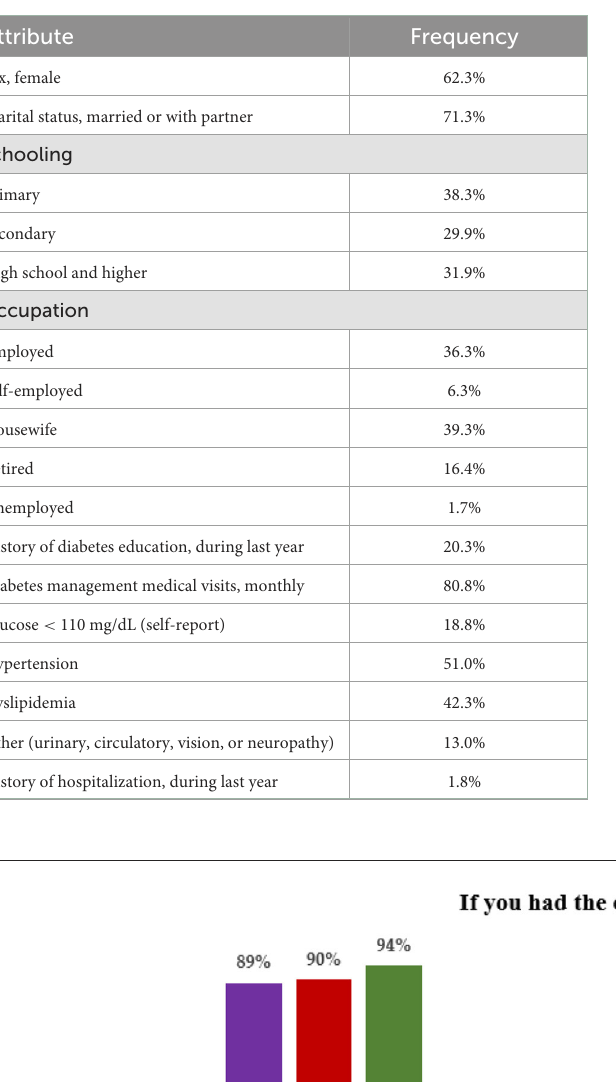
TABLE 1 Sociodemographic and comorbidity profile ( n = 907).